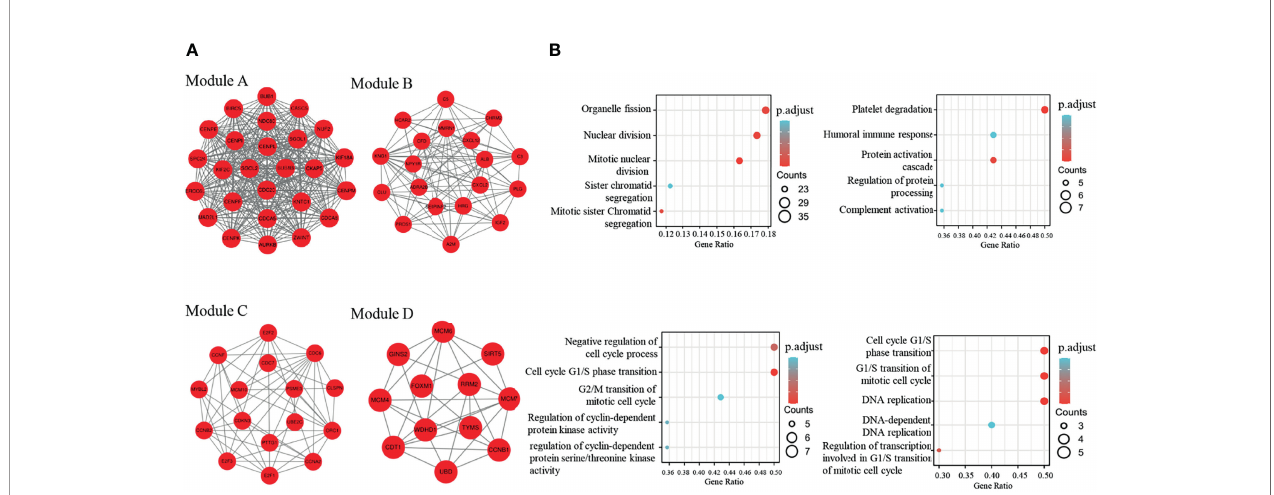
FIGURE 3 | Four modules extracted from the PPI network and GO-BP enrichment analysis of the four modules (A) The four modules in the ppi network with a score>5; (B) Top5 of GO-BP enrichment analysis of genes in the four